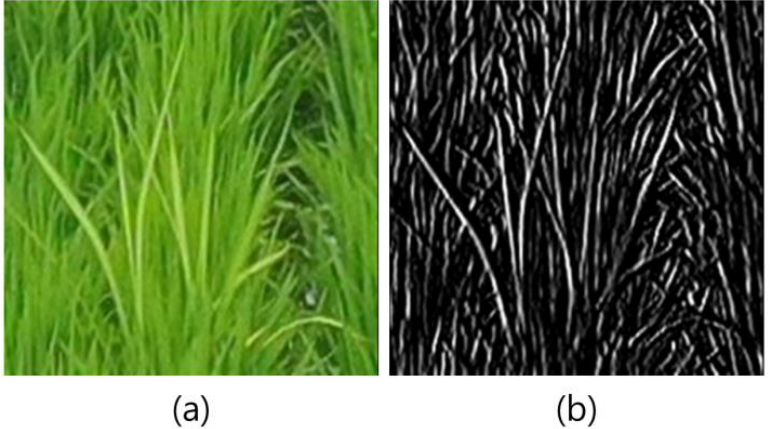
Figure 8. The edge detection of images containing RBD: ( a ) Original image, and ( b ) edge image containing gradient magnitude values.